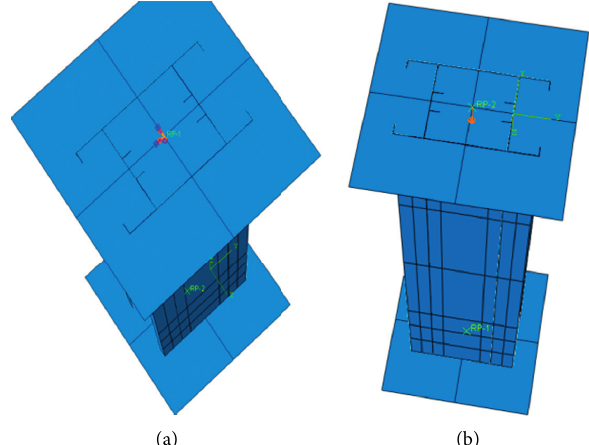
Figure 33: End plate constraint schematic: (a) lower end plate constraint and (b) upper end plate